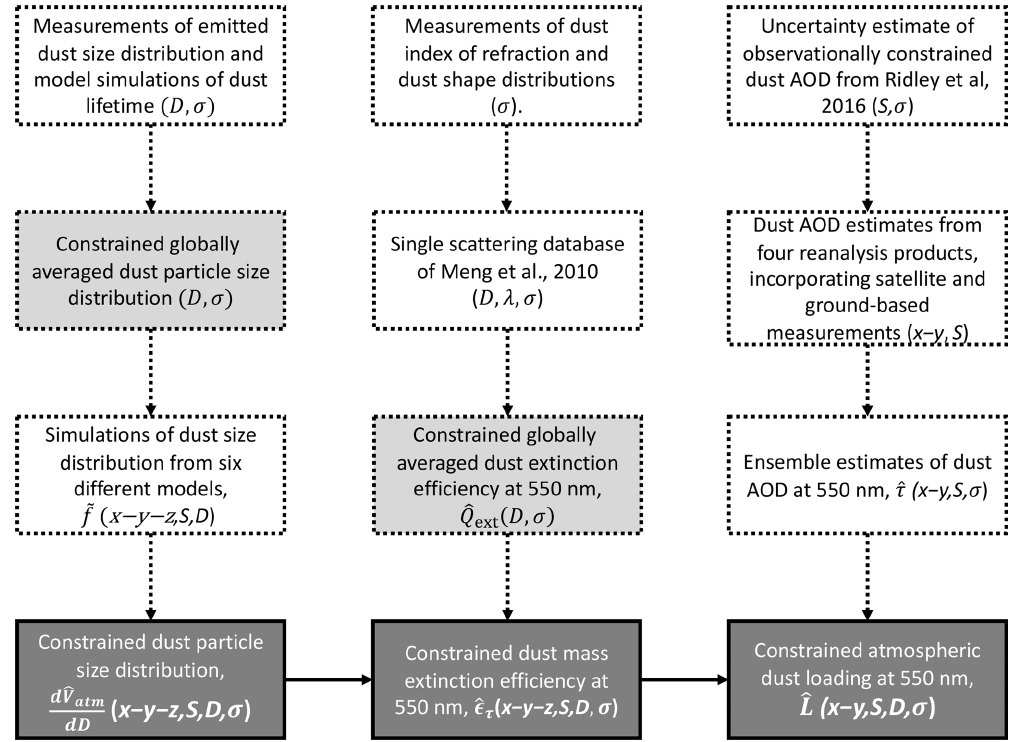
Figure 1. Schematic of the key steps to obtain the DustCOMM products (dark shaded boxes): constraints on the 3-D dust size distribution, 3-D mass extinction efficiency, and 2-D atmospheric loading. The variables are a function of the following: x – y – z (three-dimensional field), x – y (two-dimensional field), S (seasonally resolved), D (size-resolved), and σ (includes uncertainties). The variables in the light grey boxes are obtained from Kok et al. (2017). See Sect. 2 for